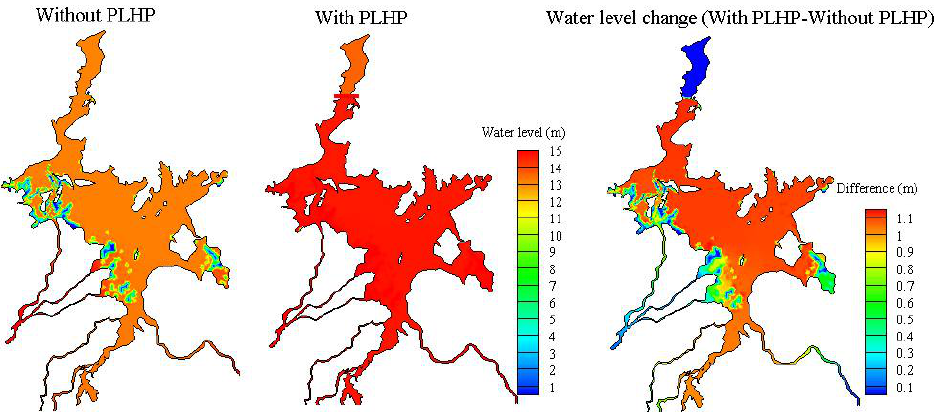
Figure 6. Influence of the PLHP on spatial water levels averaged over the storage period of the PLHP. Positive differences indicate that the water level in the scenario with PLHP is higher than the natural condition.